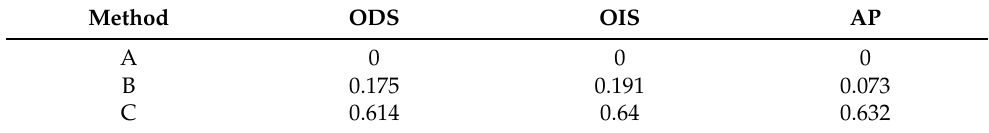
Table 4. Evaluation metrics for the crack detection of three different methods on